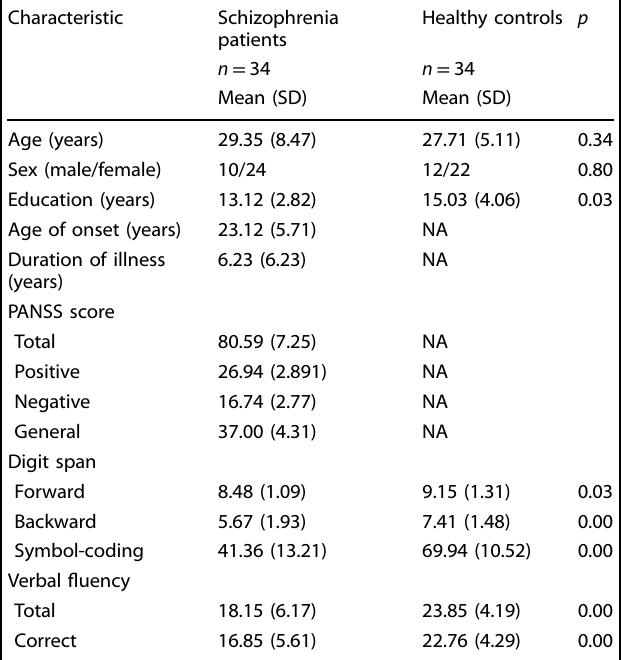
Table 1. Demographic and clinical features of the participants in each group